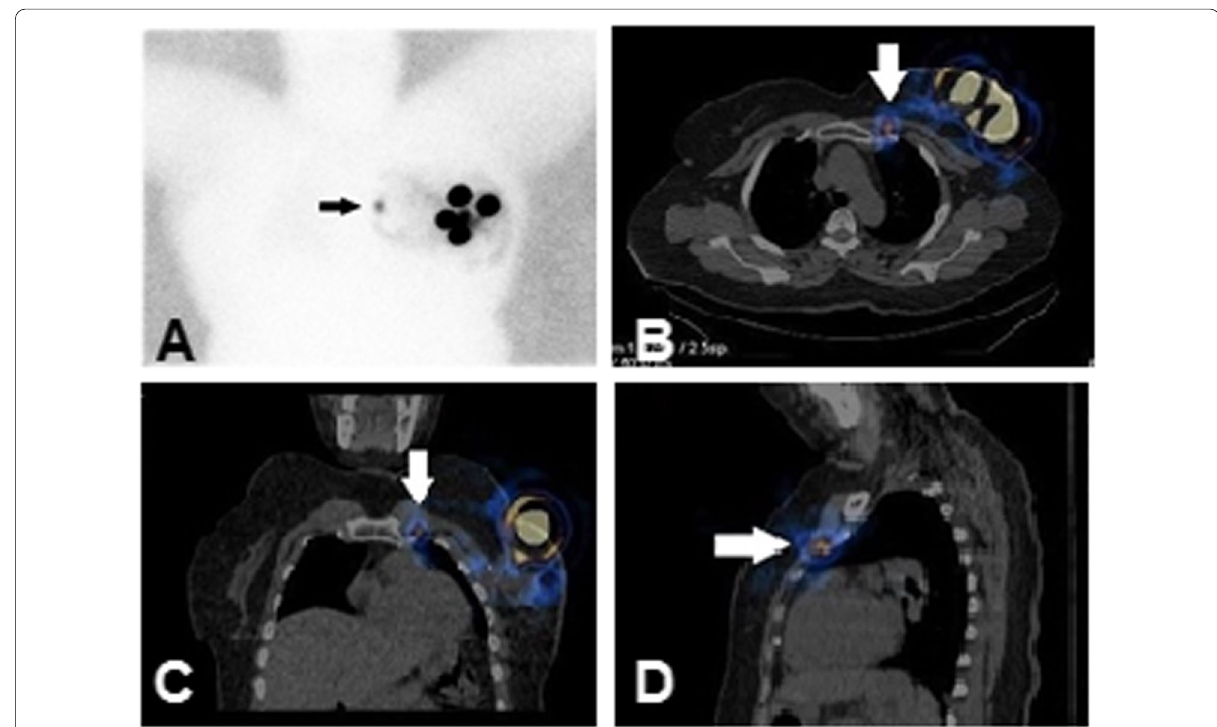
Fig. 3 A 43-year-old female with invasive ductal carcinoma of the left breast. A , B PS demonstrates multiple lymphatic channels with tracer accumulation near the parasternal area, as shown with the arrow. C , D Hybrid SPECT/CT demonstrates the focus of activity at the inferior border of the left first rib medially(arrow), i.e., Intra-thoracic (internal mammary) nodal